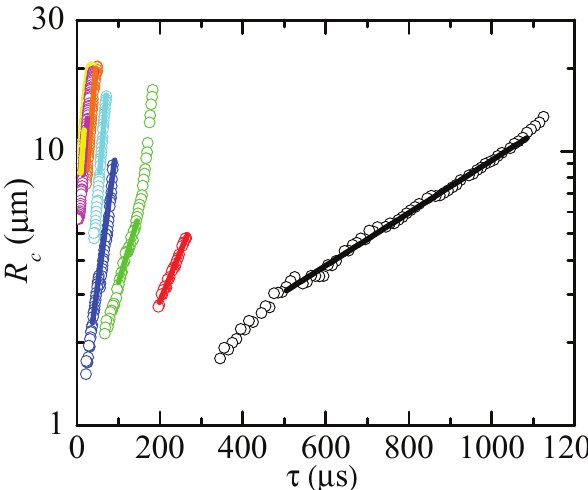
Figure 7. R c as a function of the time to pinching τ for PEO100K-0.01 (yellow), PEO100K-0.05 (magenta), PEO100K-0.1 (orange), PEO100K-0.2 (cyan), PEO100K-0.5 (blue), PEO100K-1 (green), PEO100K-2 (red) and PEO100K-5 (black). The solid lines are the fits of the function (8) to the experimental